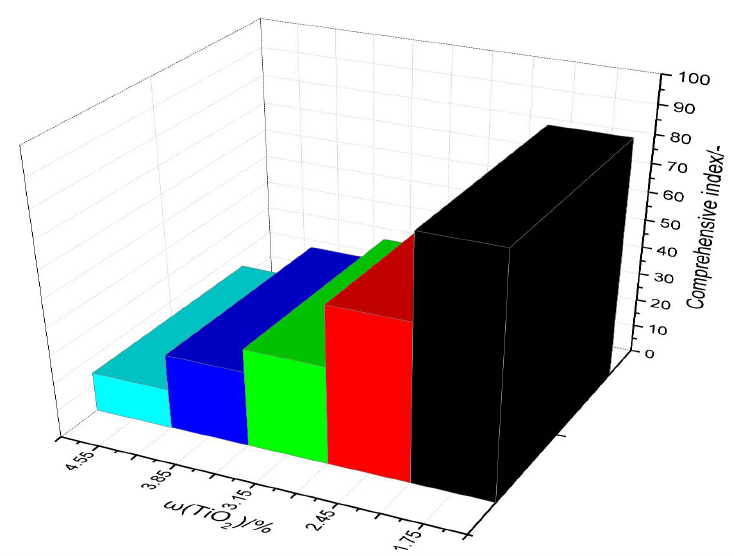
Figure 10. Comprehensive evaluation results of the sinter with different TiO 2 contents.